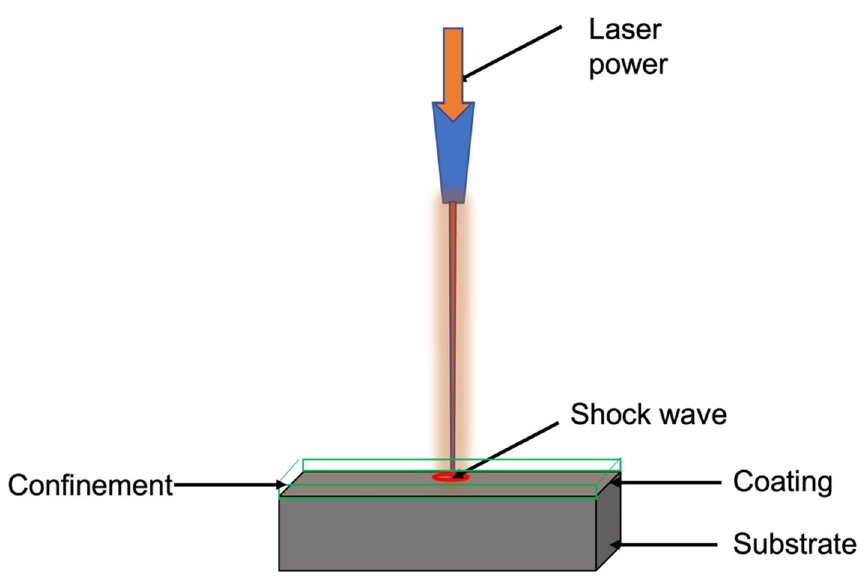
Figure 1. Schematic of LSP.